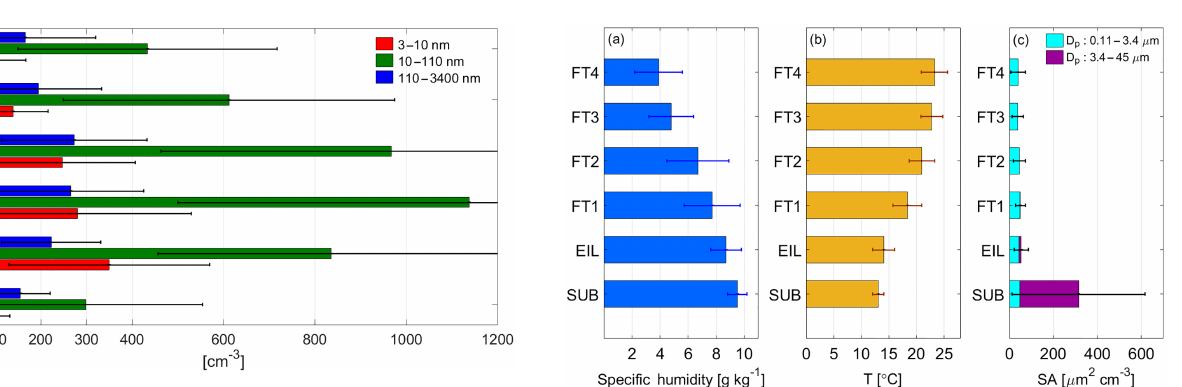
Figure 4. (a) Specific humidity, (b) temperature, and (c) particle surface area (SA) concentrations for the SUB, EIL, and FT layers. The FT is divided into four layers based on 100m increments above the EIL top. Particle SA concentrations are shown separately for the following diameter ranges: 0.11–3.4µm, 3.4–45µm. Whiskers represent 1 standard